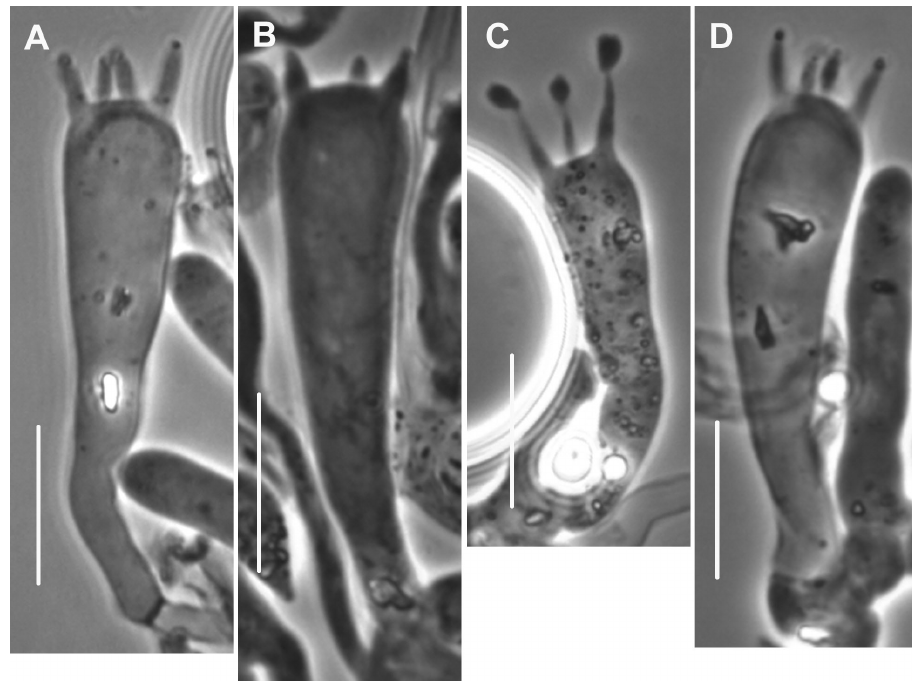
Figure 74. Mycetinis scorodonius . Basidia. Standard bars = 10 µm. TFB 7261